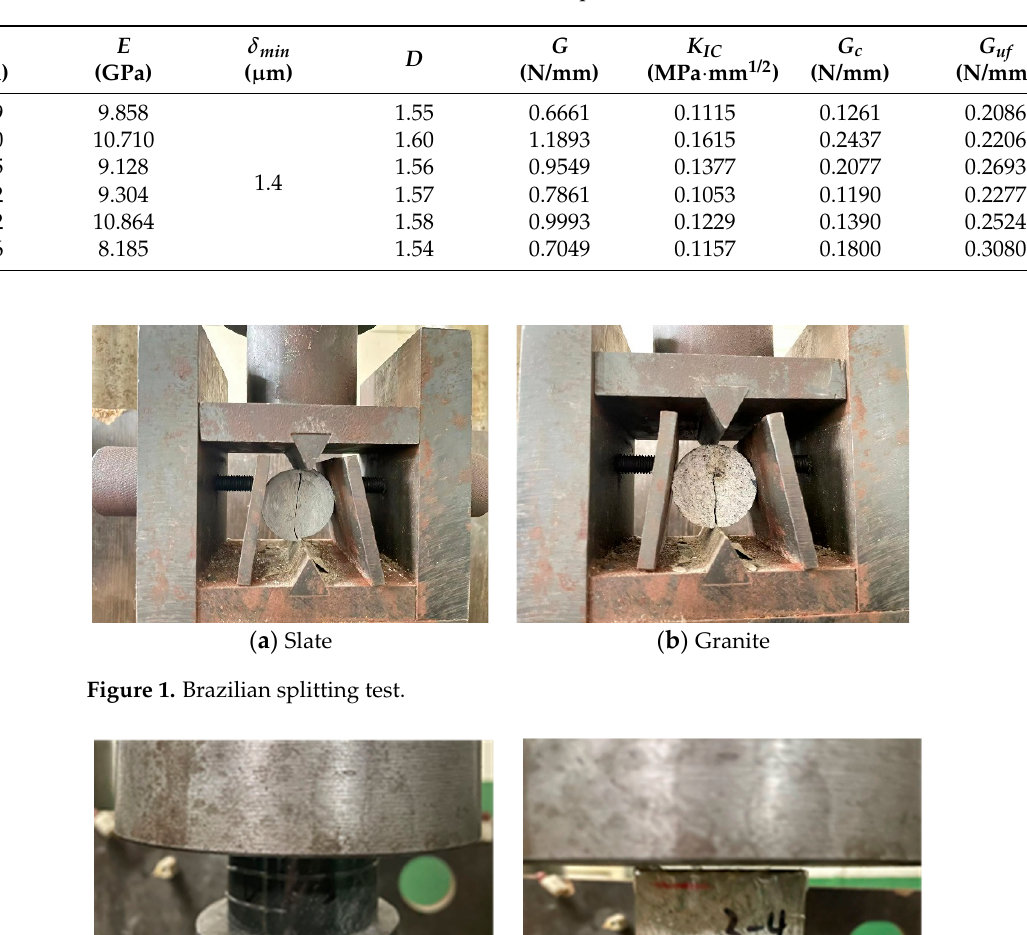
Table 1. Test data and calculation results of slate specimens.